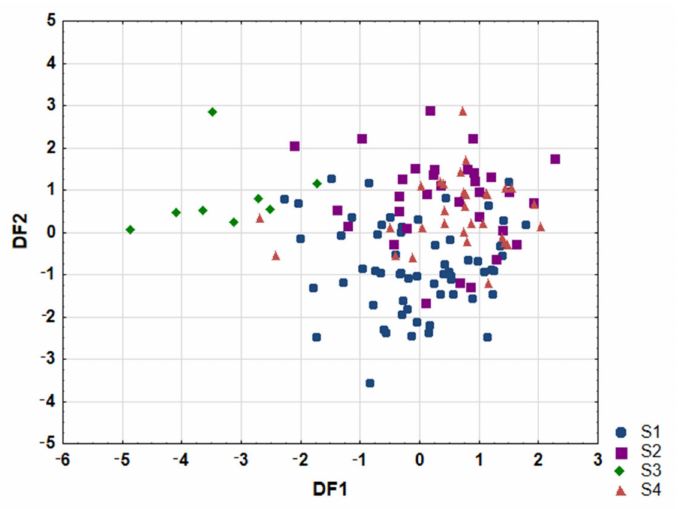
Figure 3. Scatterplot of canonical values for functions DF1 and DF2. Sk1-Sk4—distinguished clusters. The calculated classification matrix indicated that average classification